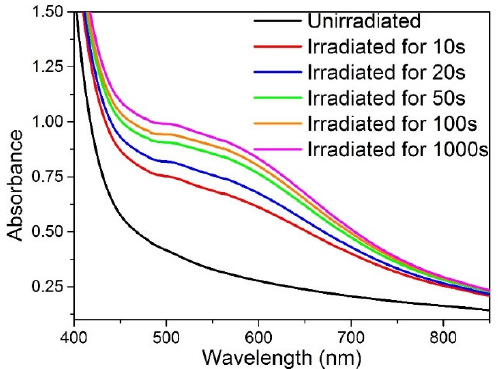
Figure 10. Absorbance spectra of the PTR-Br glass sample ion-exchanged for 9 h and heat-treated at 500 ◦ C for 9 h after irradiation with UV pulses for different